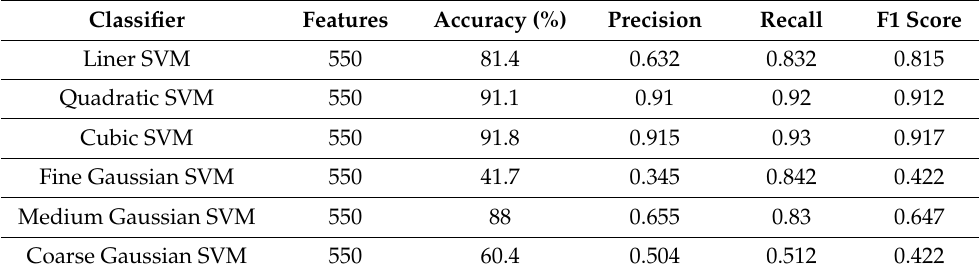
Table 2. Experiment Setup 2.